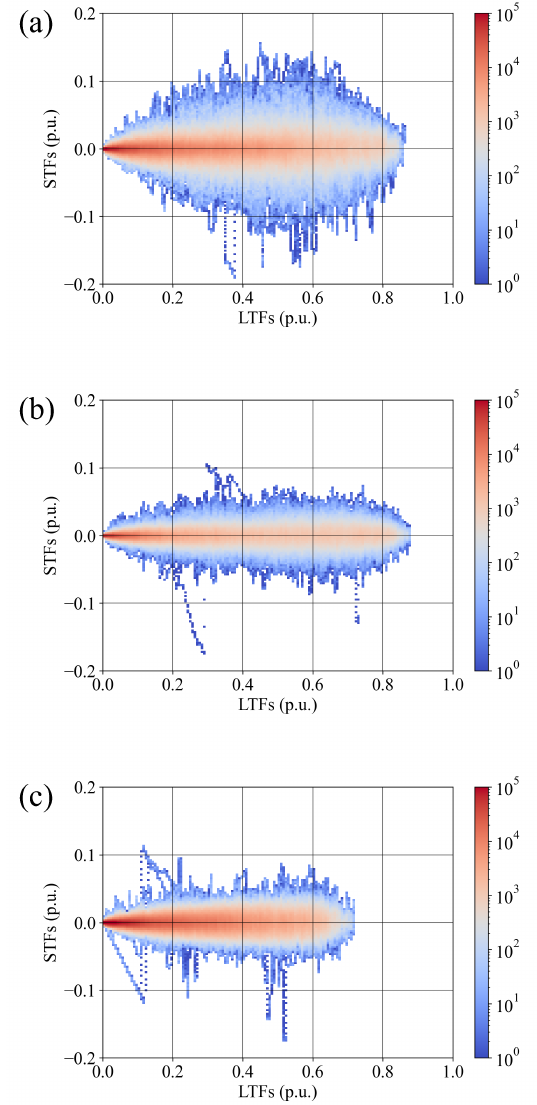
Figure 8. Scatter diagrams of short- (STFs) versus long-term fluctuations (LTFs) in the ( a ) Hokkaido, ( b ) Tohoku, and ( c ) Kyushu areas in the 2012 fiscal year. Data point density is reflected by the colors: high (low)-density data are indicated by red (blue)